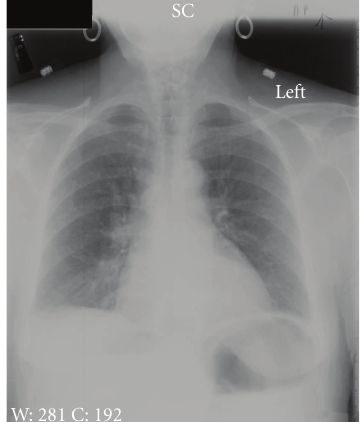
Figure 3: PA chest radiograph from the patient’s readmission to the hospital. There is a large right pleural e ff usion, with an air- and fluid-filled structure noted